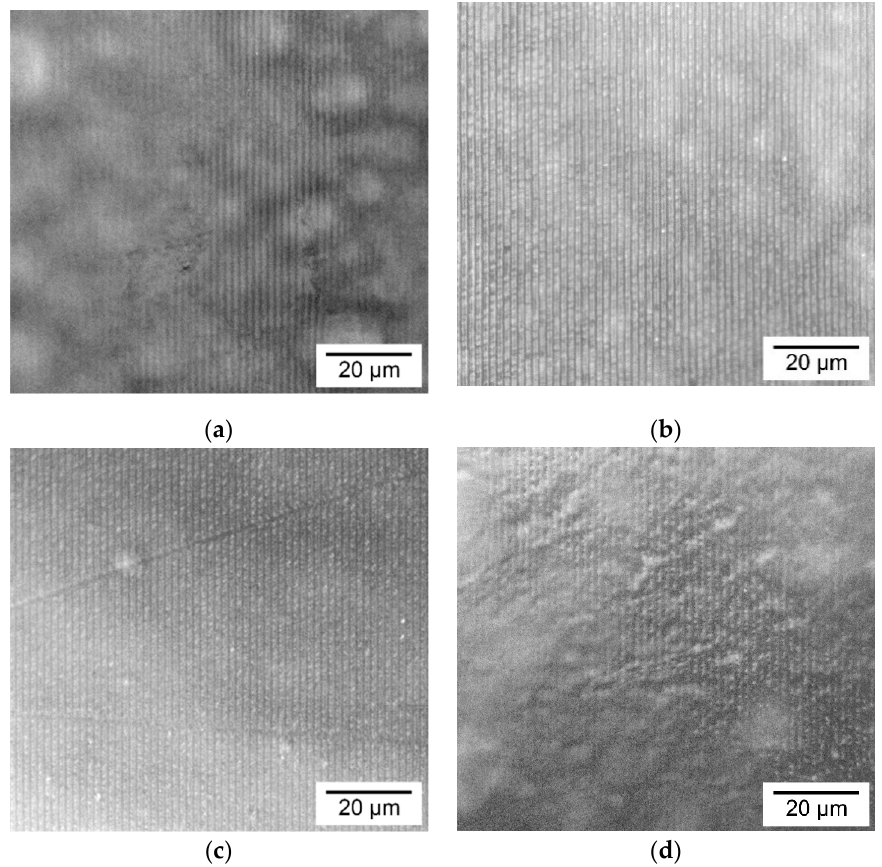
Figure 4. Reflected microphotographs of the holographic markers on the coatings surface made from starch/gelatin blend in the ratios of ( a ) 70/30; ( b ) 50/50 wt.%; and from starch/agar blend in the ratios of ( c ) 70/30; ( d ) 50/50 wt.%.